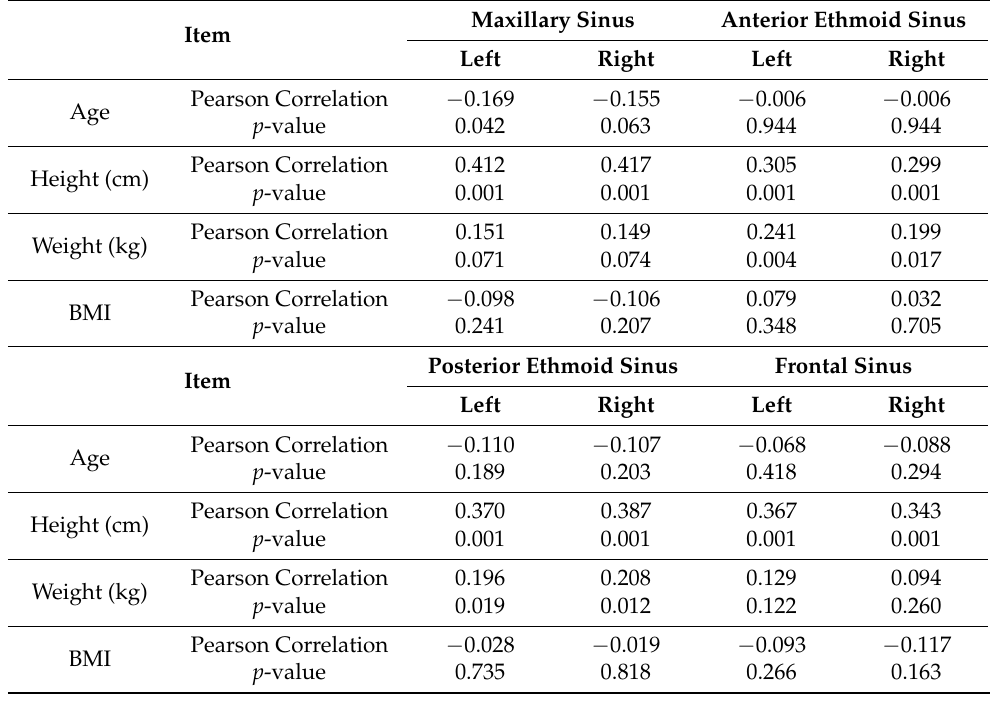
Table 9. Relevance analysis